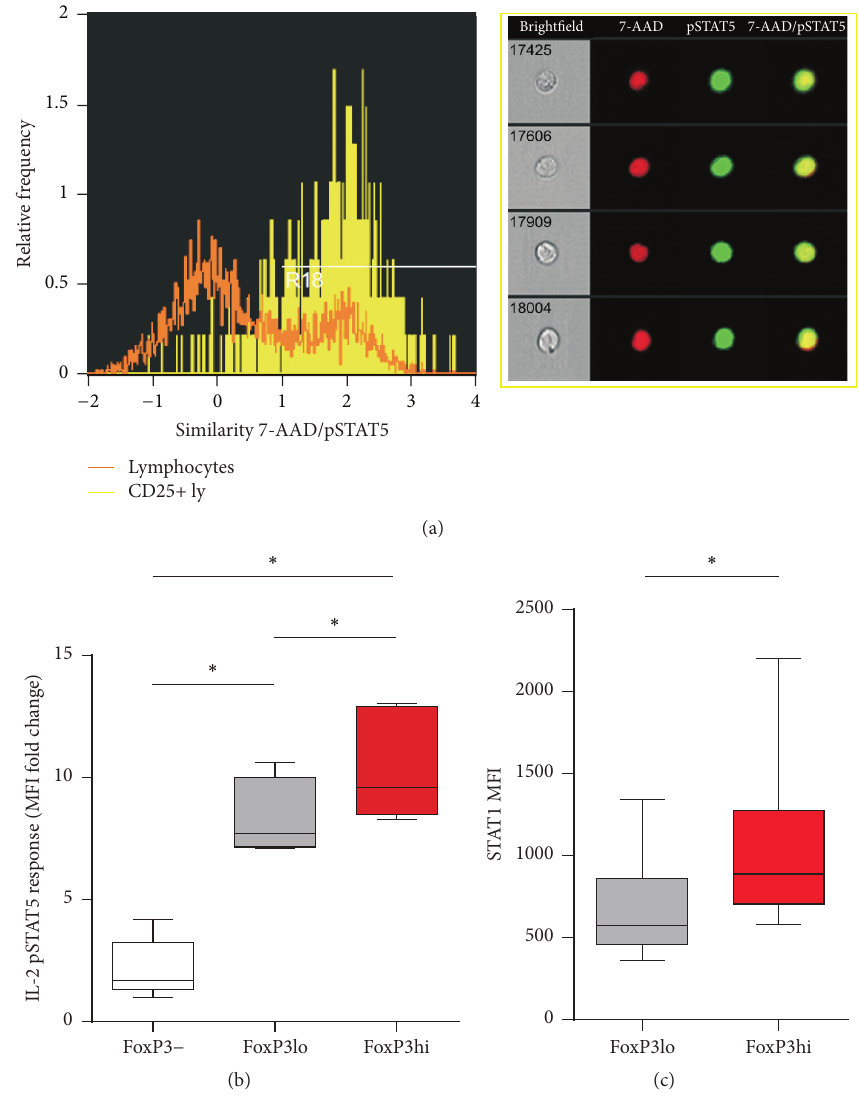
Figure 4: Th subset differences in STAT5 phosphorylation responses and STAT1 protein expression. (a) Colocalization of pSTAT5 within the 7-AAD stained nucleus after IL-2 stimulation in CD25+ T lymphocytes quantified by imaging flow cytometry as described in Section 2. Left: representative histograms of 7-AAD/pSTAT5. Similarity scores correlating 7-AAD nuclear stain with the pSTAT5 signal in CD25+ T lymphocytes (yellow) as compared to all lymphocytes (orange) gated on FoxP3 versus pSTAT5 dot plot are shown on the left. The higher the Similarity score is, the more the translocation is visualized in the example images of cells shown on the right: pSTAT5 (green) is specifically localized tothenucleus stainedwith 7-AAD (red)inCD25+Tlymphocytes. (b)pSTAT5 responseto IL-2stimulationinwholeblood CD4+Th lymphocytes and their FoxP3+ and FoxP3 − subsets from healthy donors was assayed by measuring median fluorescence intensities (MFI) and represented as a ratio of induction to baseline levels (MFI fold change = MFI cytokine-stimulated/MFI unstimulated cells). Box and whisker plots of pSTAT5 response after IL-2 stimulation in FoxP3hi expressing aTregs as compared to FoxP3lo and FoxP3 − Th subsets from healthy donors ( 𝑛 = 7 ). (c) Box and whisker plots of STAT1 protein expression in FoxP3hi expressing aTregs as compared to FoxP3lo expressing Th subsets from healthy donors ( 𝑛 = 6 ). 𝑃 values were calculated using the Wilcoxon matched-pairs signed-rank test. ∗ 𝑃 < 0.05 ; ∗∗ 𝑃 < 0.01